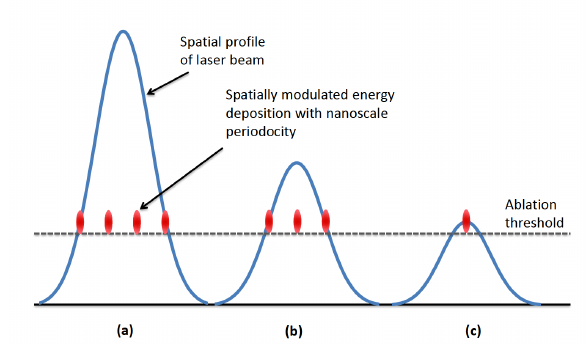
Figure 7: Schematics for spatially modulated energy deposition with nanoscale periodicity at the focal spot. As the pulse energy is reduced, the number of cycles of the modulated energy distribution decreases.